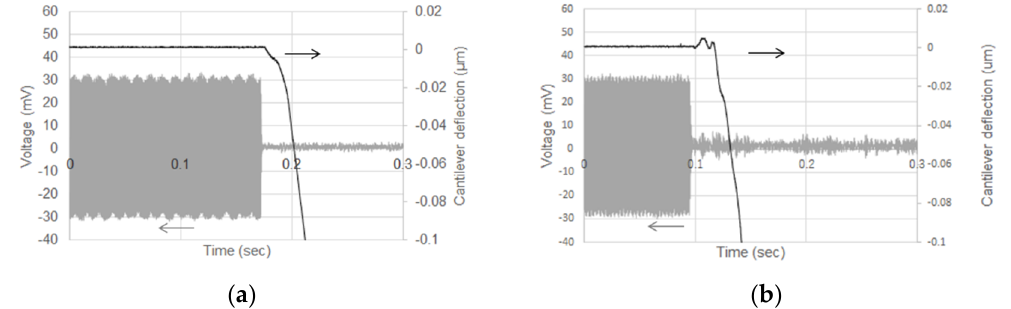
Figure A2. Results obtained simultaneously for the capacitor voltage of the comb drive of the nanotweezers and cantilever deflection: ( a ) without particle; ( b ) with polystyrene particle.